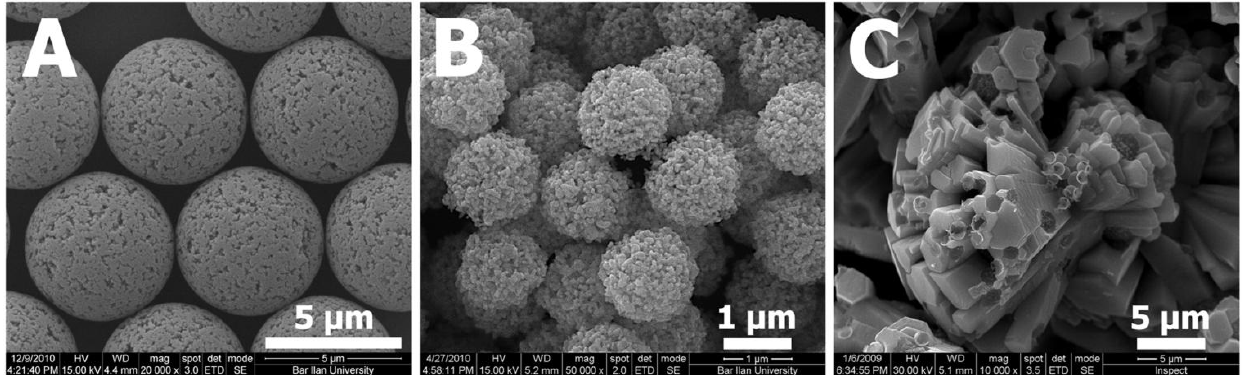
Figure 6. SEM images of ( A ) polydivinyl benzene (PDVB) template microspheres; and ( B ) ZnO microparticles prepared using the zinc acetate precursor; or ( C ) the ZnCl